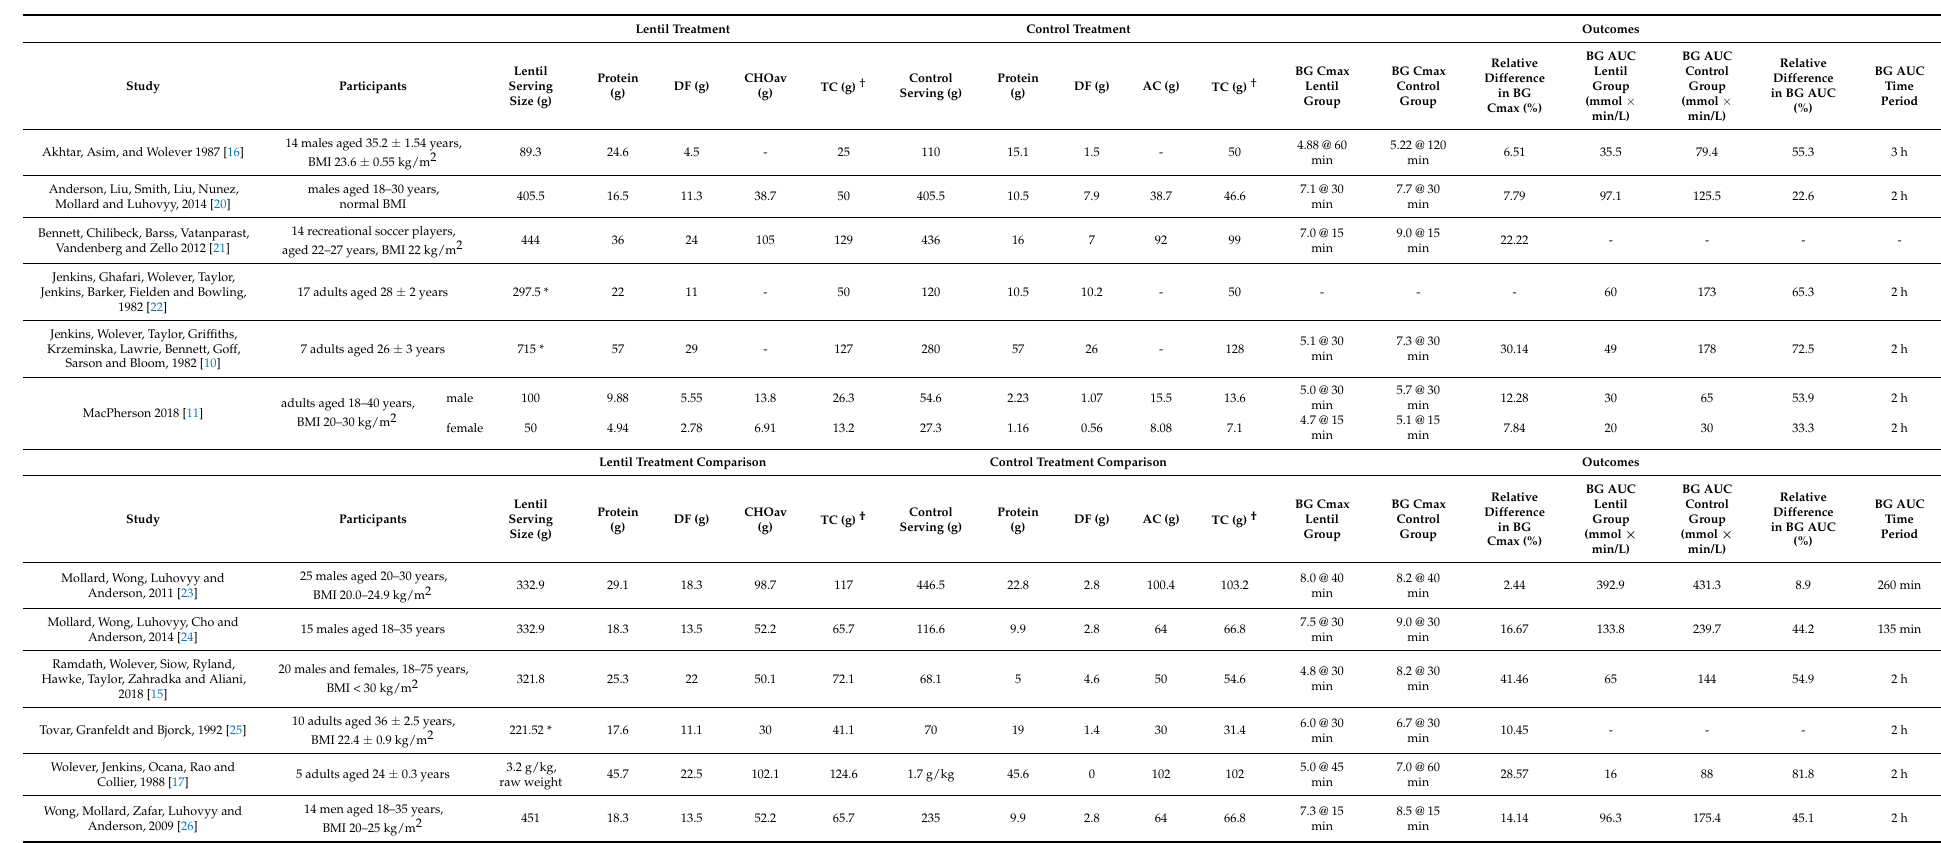
Table 1. Summary of data obtained from studies involving healthy